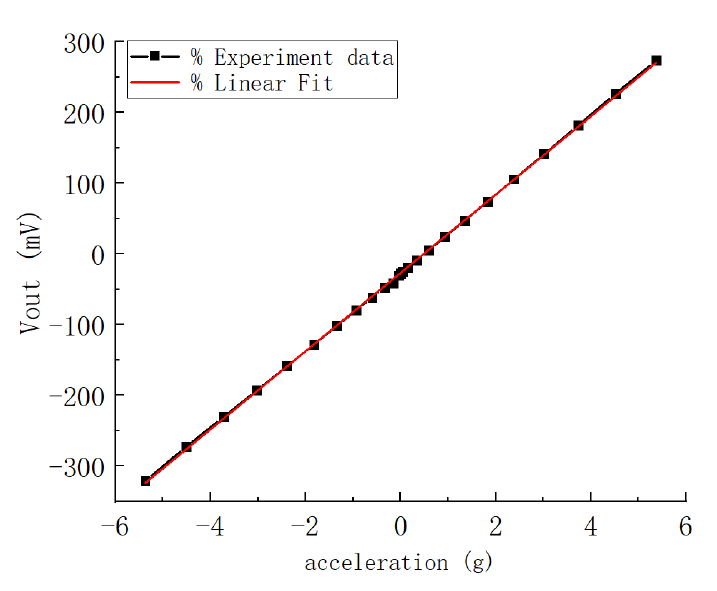
Figure 9. Relationship between the output voltage and the applied acceleration.